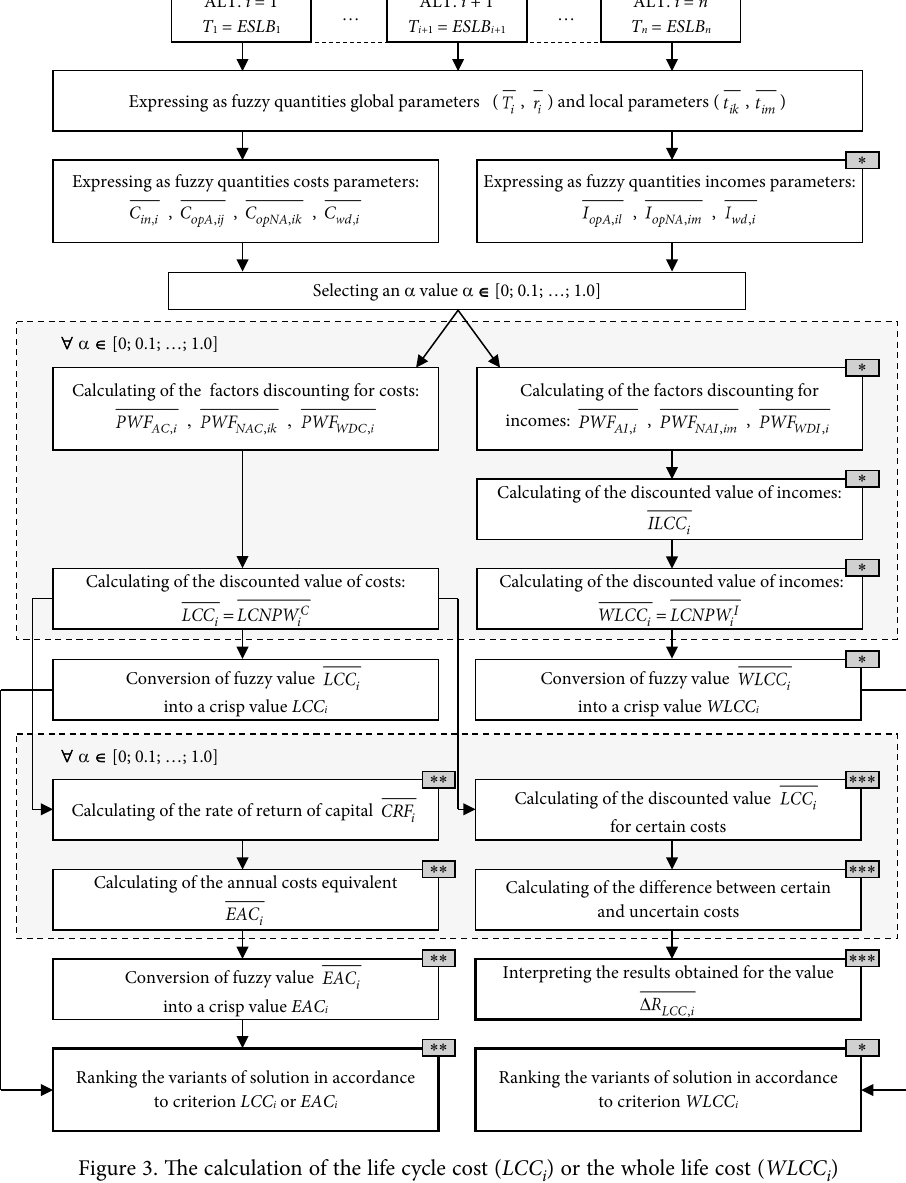
Figure 3. The calculation of the life cycle cost ( LCC i ) or the whole life cost ( WLCC i ) of the i-th building object variant